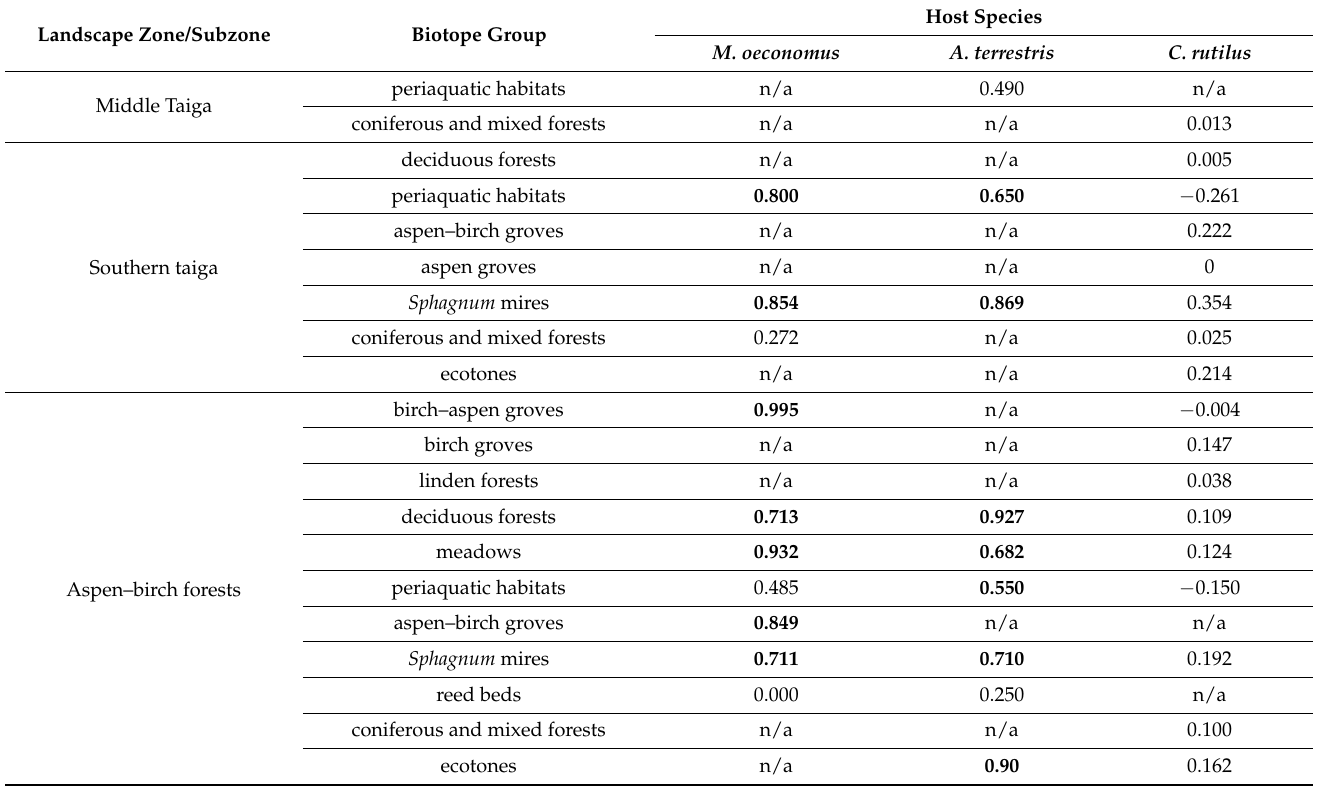
Table 3. Values of I HT calculated for I. apronophorus in different biotope groups in West Siberia. The values showing the significant relationship with the host (>0.50) are given in